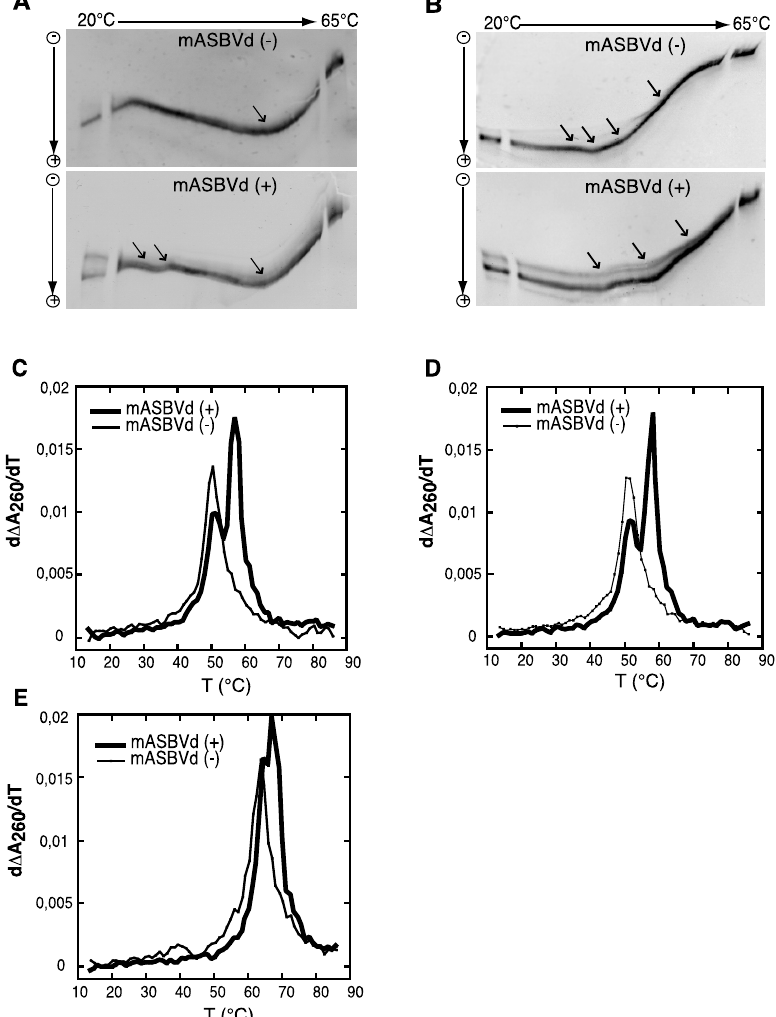
Figure 2. Temperature gradient gel electrophoresis ( TGGE) and melting curves of mASBVd (+) and mASBVd ( − ) transcripts. ( A ) TGGE analysis performed by native 8% PAGE in 0.2× TBE buffer. ( B ) TGGE analysis performed by native 8% PAGE in 0.2× TB buffer containing 20  M magnesium acetate. Migration was monitored between 20 °C and 65